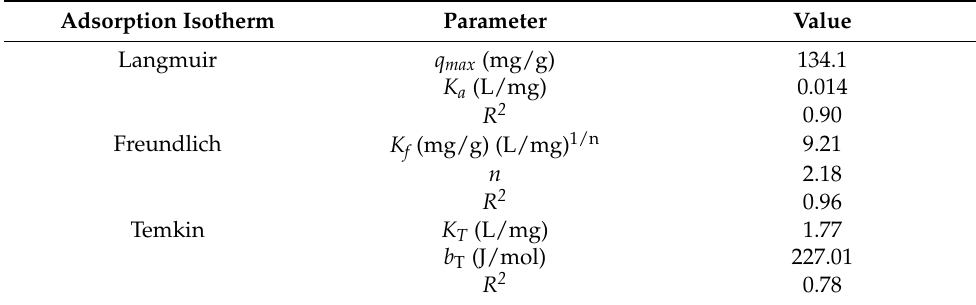
Table 8. The parameters of isotherm models for MV 2B adsorption onto MCAC.